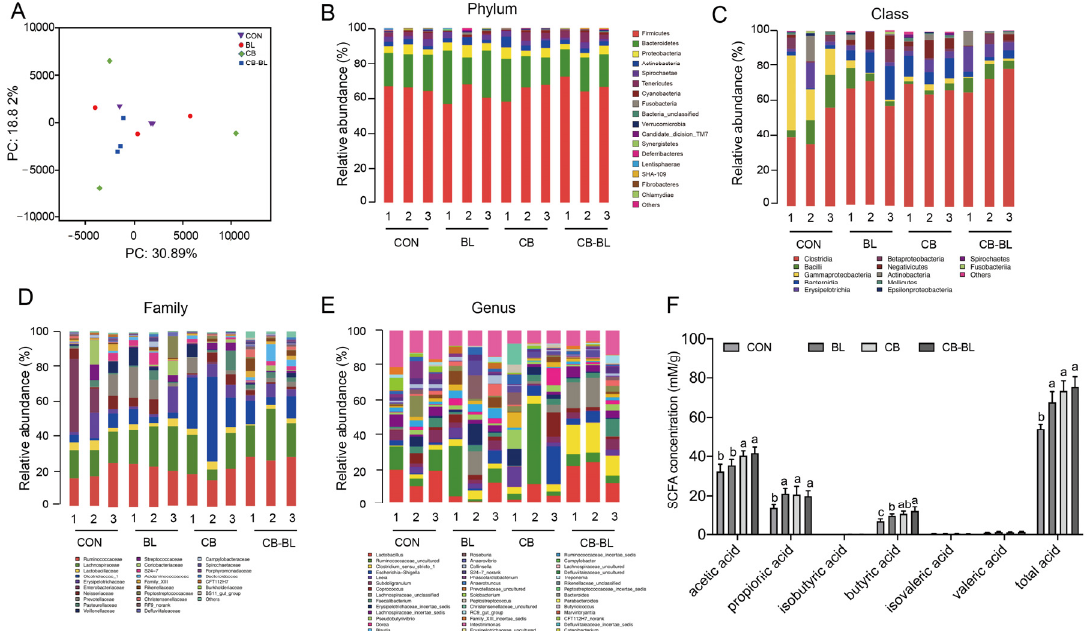
Figure 4. Changes in gut microbial community and SCFAs in weaning piglets after probiotics treatment. ( A ) Multiple sample PCA analysis of bacterial in weaned piglets fed each diets; purple inverted triangle, CON; red circle, BL; green diamond, CB; blue square, CB-BL. ( B ) Microbial community bar plot by phylum. ( C ) Microbial community bar plot by class. ( D ) Microbial community bar plot by family. ( E ) Microbial community bar plot by genus. ( F ) Changes of SCFAs concentrations in cecal contents of piglets fed. The data are expressed as the mean ± SEM, n = 3 ( A – E ), n = 6 ( F ), biological replicates; bars with different small capital letters are statistically different from one